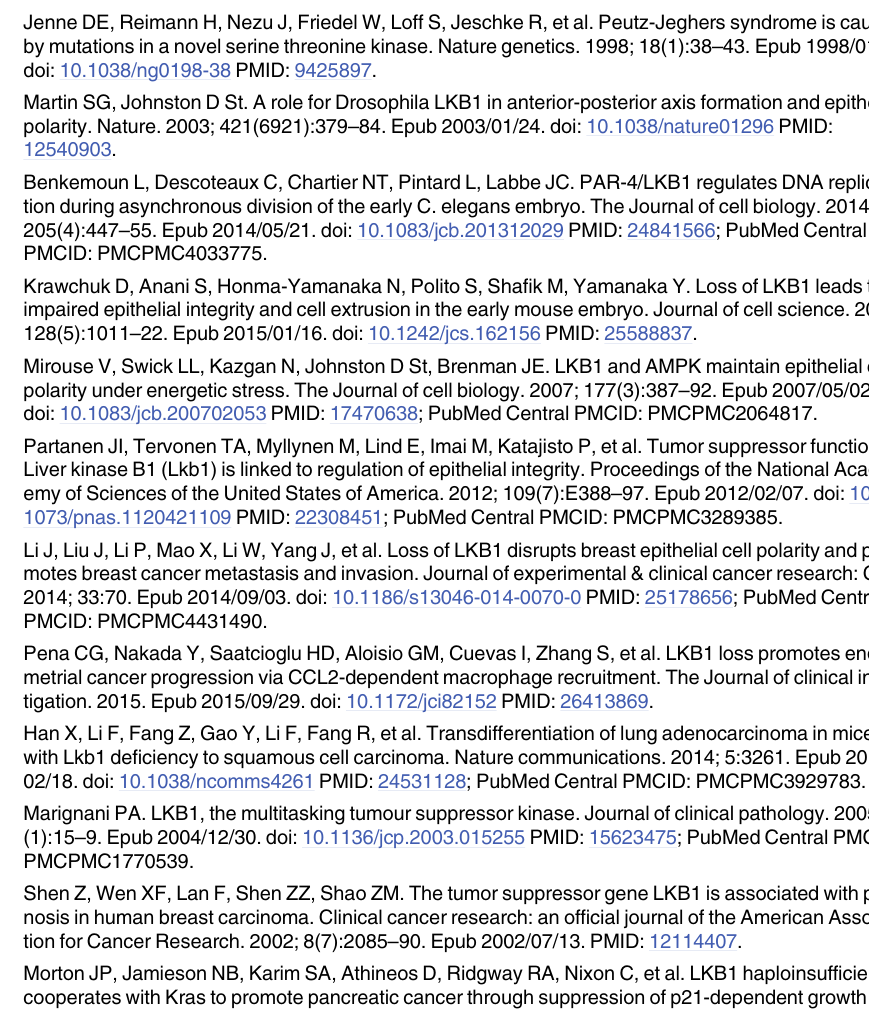
S2 Table. Quality assessment of the 14 included studies according to the NOS. S3 Table. Summarized data of clinical and pathological parameters from the eligible stud-